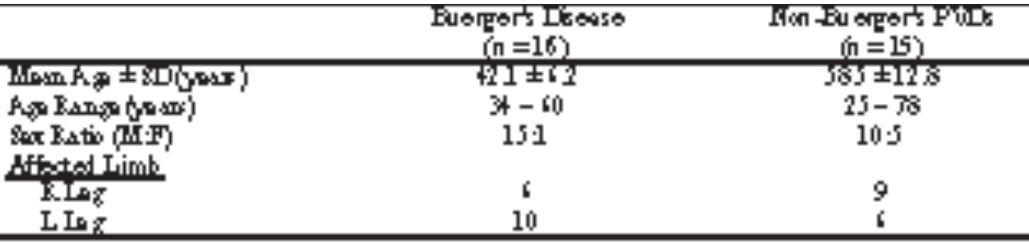
Table I : Demographic Data and Affected Limbs